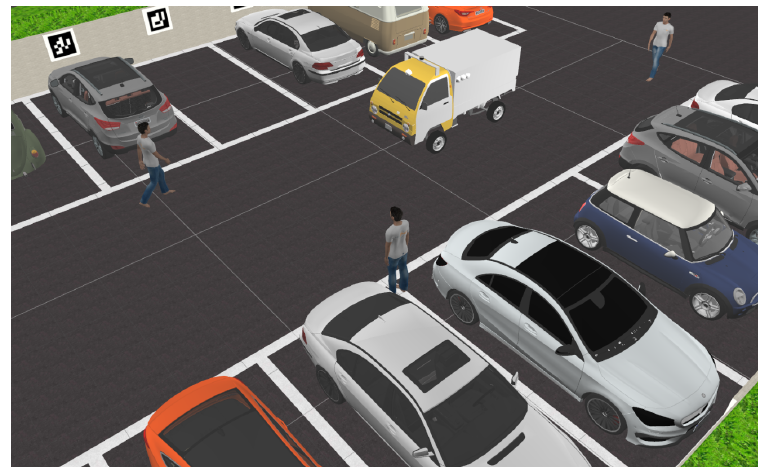
Figure 5. Parking lot scenario developed in ROS and Gazebo Simulator to check the proposed system. The AV is looking for a free parking space in the parking lot and it is navigating among pedestrians and other vehicles depending on the data coming from the perception system and analyzed with the rational agent onboard the AV. The information obtained from the perception system is shown below in Figures 6 and 7.